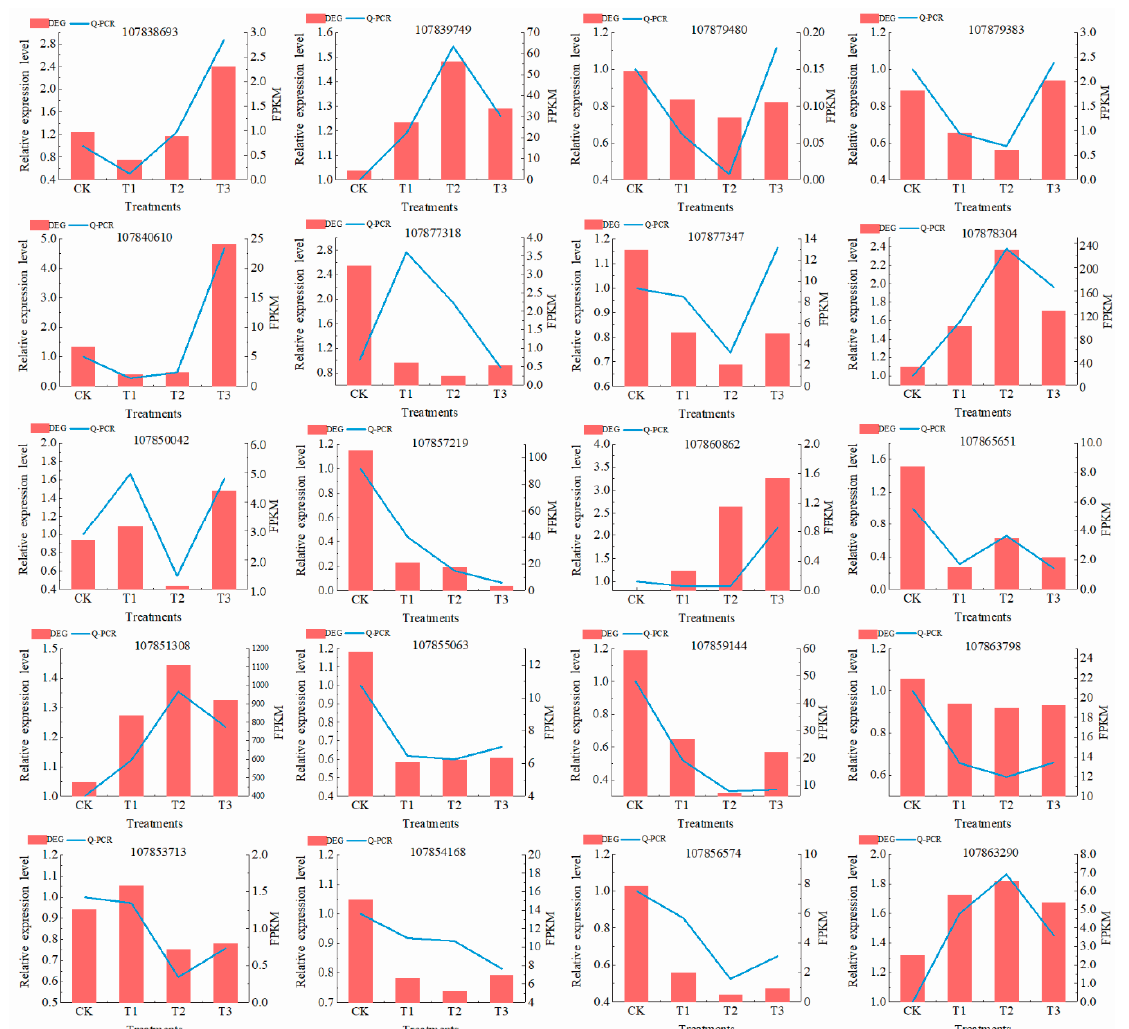
Figure 5. Real-time quantitative PCR (qRT-PCR) validation of 20 randomly selected DEGs identified by RNA-Seq in pepper grown under CK, T1, T2, and T3 light condition. The red histograms denote the RNA-Seq results. The blue line denotes the mean value of q-PCR results.